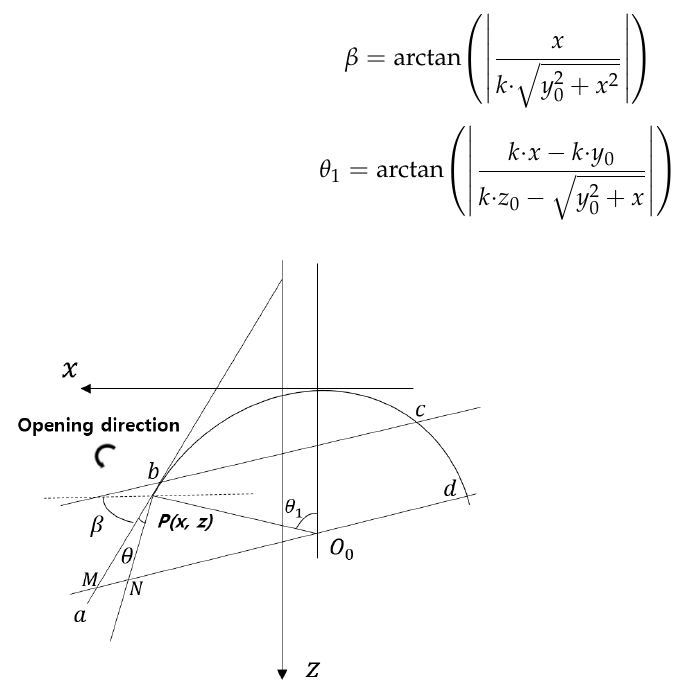
Figure 7. Contact angle of seal pair.